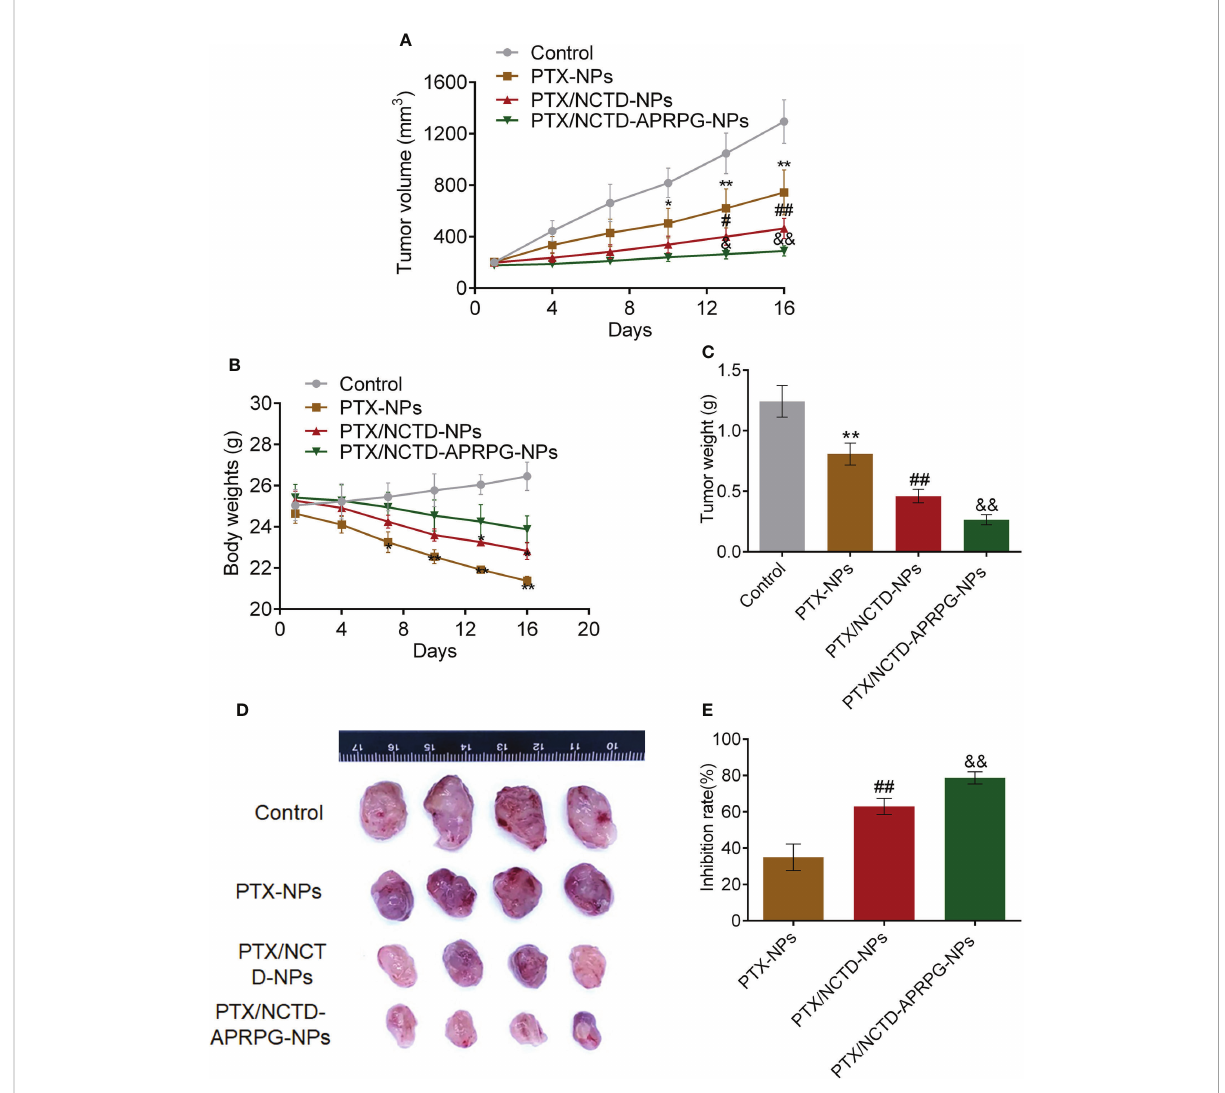
FIGURE 4 In vivo anti-tumor effects of PTX-NPs, PTX/NCTD-NPs, and PTX/NCTD-APRPG-NPs in the HepG2 xenograft mouse model. (A) Effects of PTX- NPs, PTX/NCTD-NPs, and PTX/NCTD-APRPG-NPs on the tumor volume at different time points (days 1, 4, 7, 10, 13, and 16 after the fi rst administration); (B) effects of PTX-NPs, PTX/NCTD-NPs, and PTX/NCTD-APRPG-NPs on the body weights at different time points (days 1, 4, 7, 10, 13, and 16 after the fi rst administration); (C) effects of PTX-NPs, PTX/NCTD-NPs, and PTX/NCTD-APRPG-NPs on the tumor weight on day 16 after the fi rst administration; (D) effects of PTX-NPs, PTX/NCTD-NPs, and PTX/NCTD-APRPG-NPs on the tumor size; and (E) effects of PTX- NPs, PTX/NCTD-NPs, and PTX/NCTD-APRPG-NPs on tumor growth in the HepG2 xenograft animal model. * p < 0.05 vs. control, ** p < 0.01 vs. control, # p < 0.05 vs. PTX-NPs, ## p < 0.01 vs. PTX-NPs, & p < 0.05 vs. PTX/NCTD-NPs, && p < 0.01 vs.